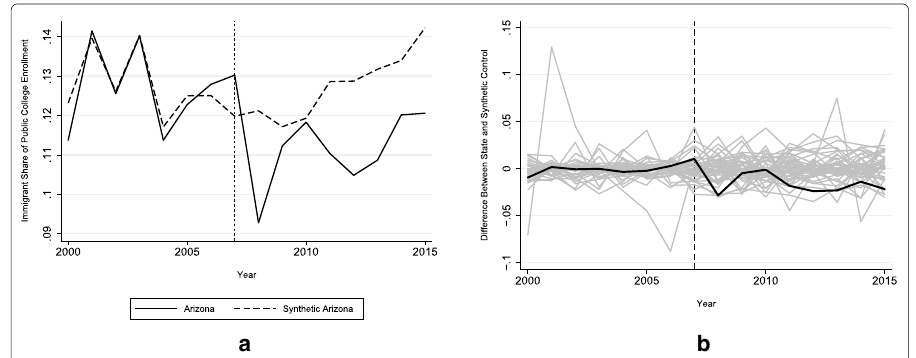
Fig. 9 LAWA and share of immigrants in public college. a Share of immigrants. b Permutation